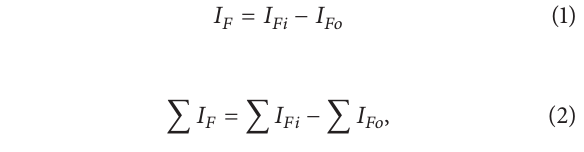
= 289, 302, 320, and 340 nm). exc